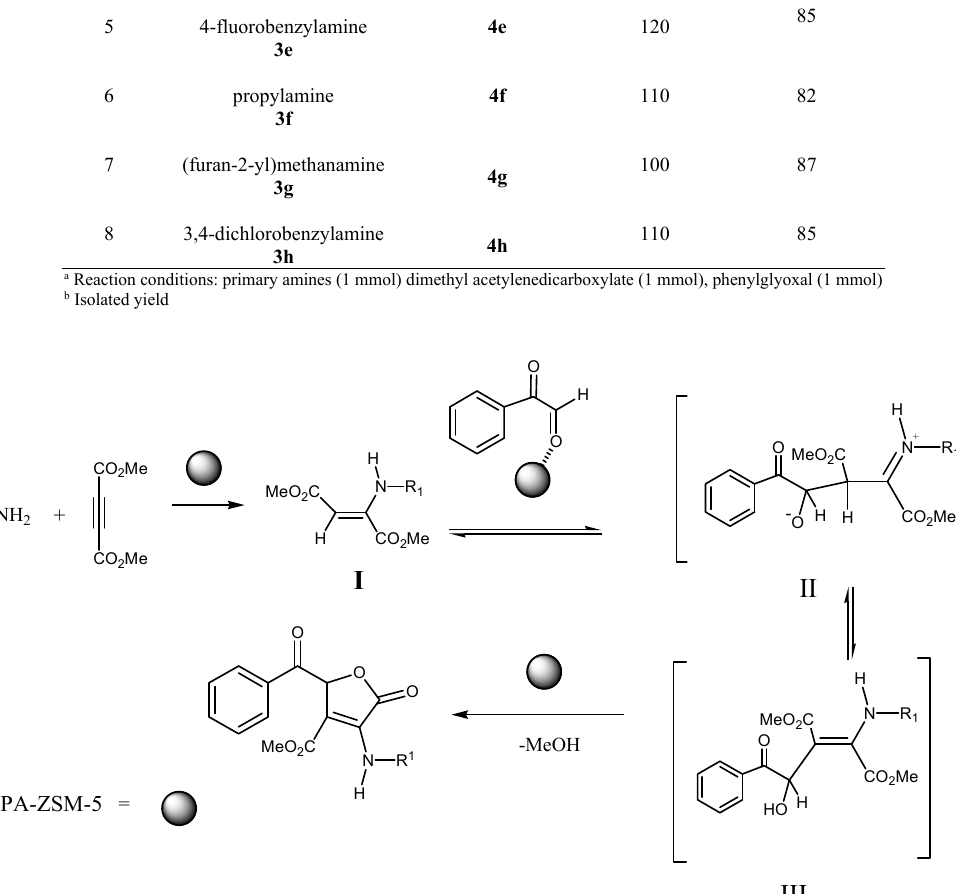
Scheme 2 . Schematic mechanism for the catalytic activity of HPA-ZSM-5 for the synthesis of furans